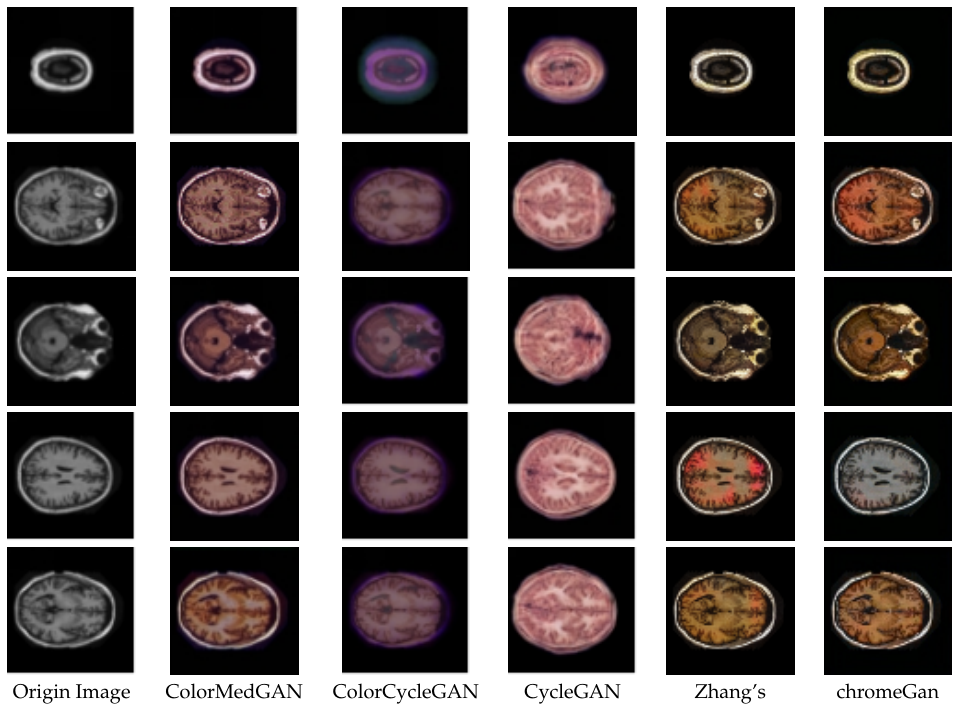
Figure 9. Results of different